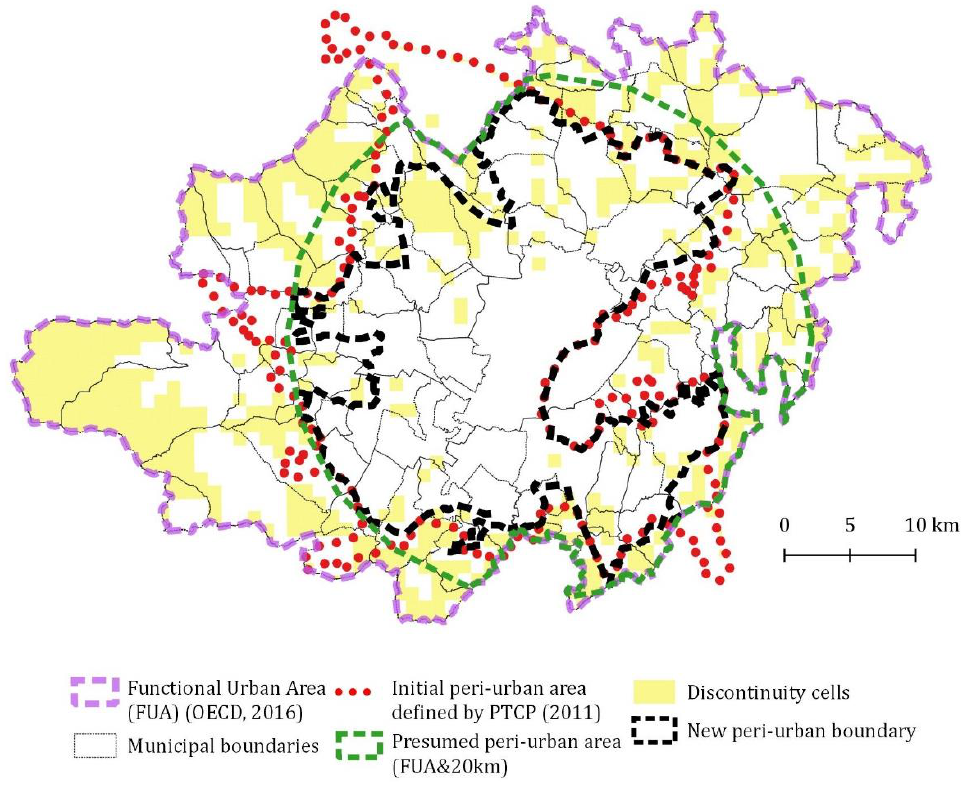
Figure 3. The perimeter of the Turin peri-urban area defined in relation to the discontinuity cells within the presumed peri-urban area and taking into account the proximity to the city center (buffer 15 km).